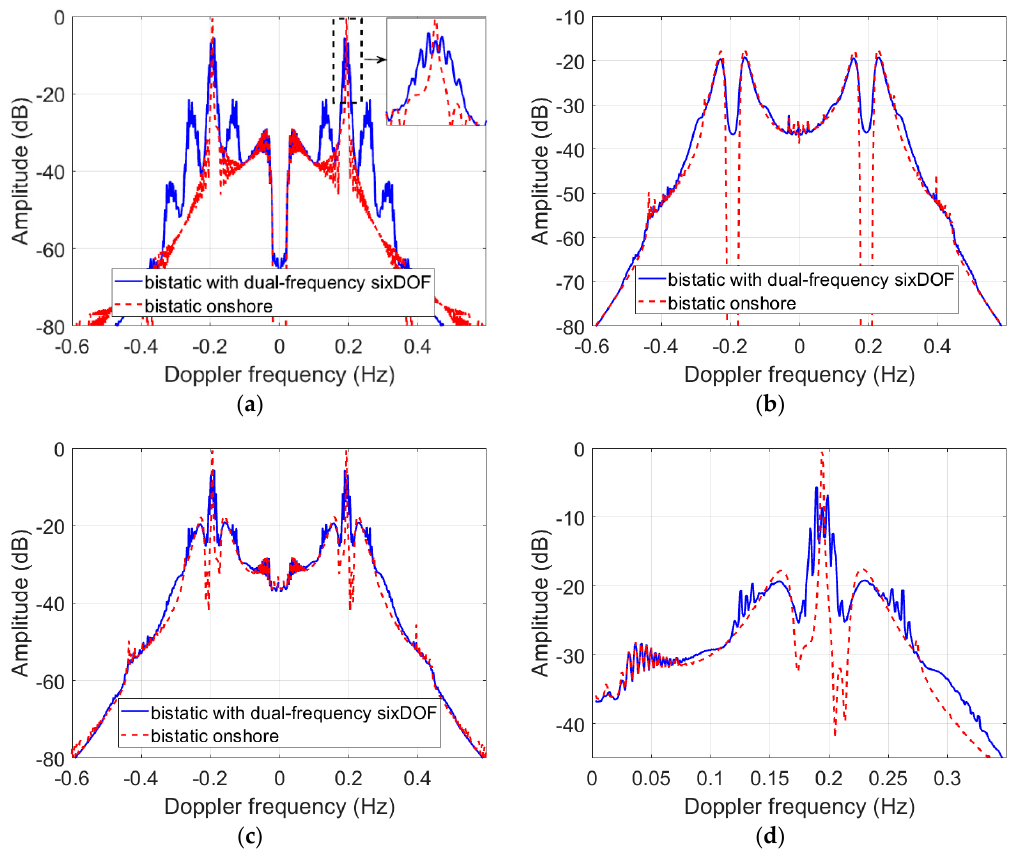
Figure 10. Simulated RCSs for a dual-frequency six DOF oscillation motion model. ( a ) First-order RCS; ( b ) second-order RCS; ( c ) total RCS; ( d ) zoomed in view of the positive Doppler frequency in (c).